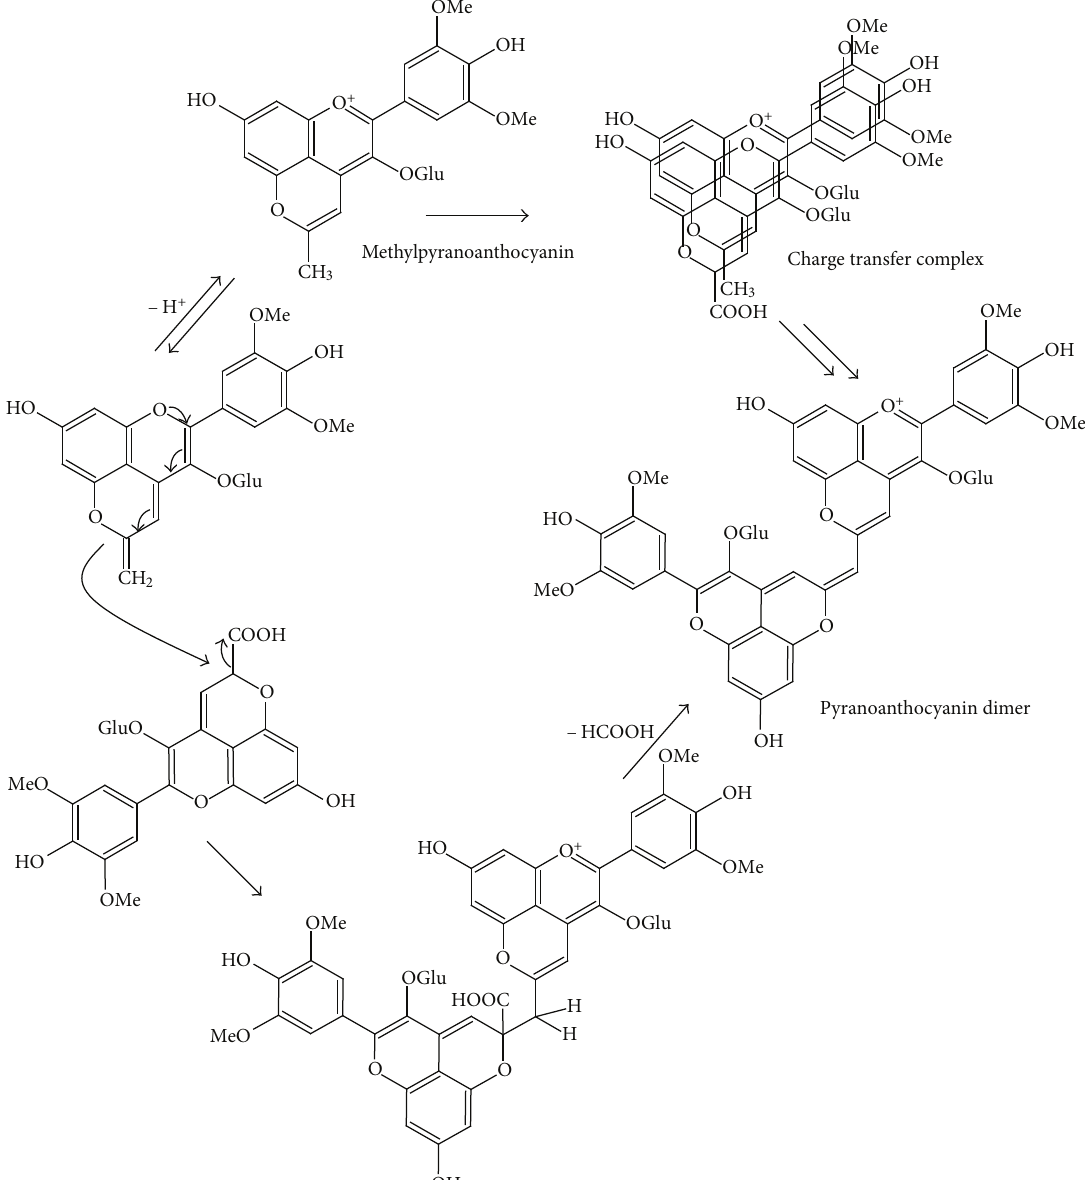
F 12: Proposed pathways for the formation of pyranoanthocyanin dimers